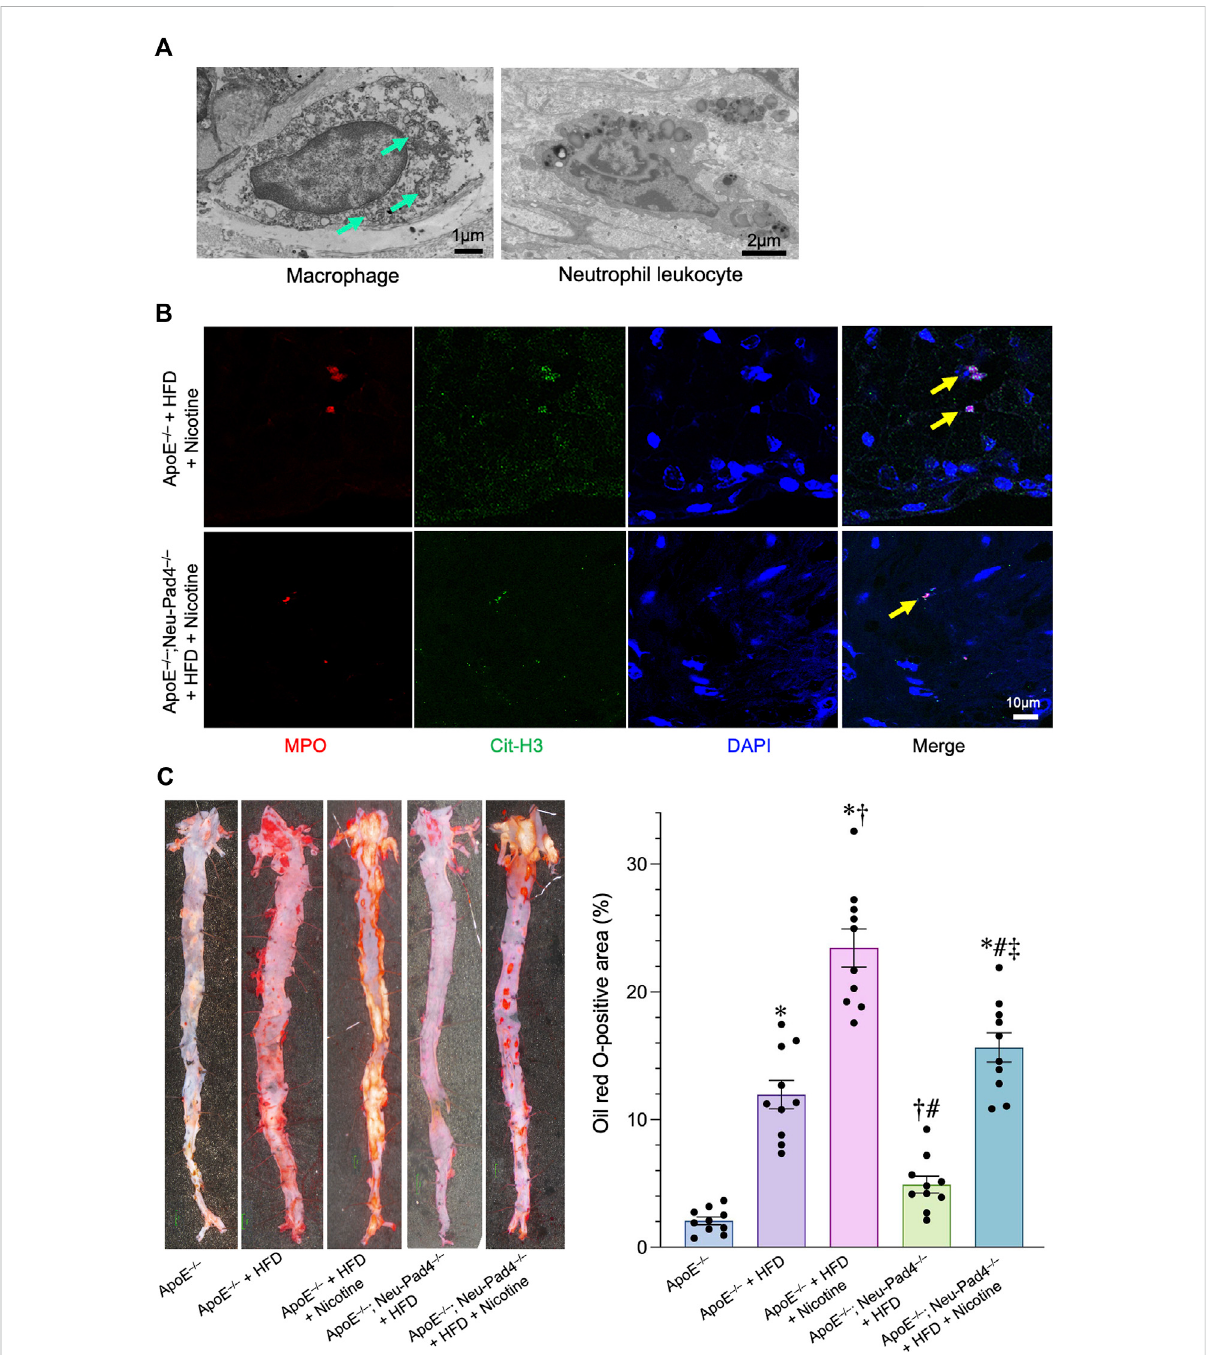
FIGURE 3 Role of NETs in the progression of atherosclerosis in high-fat diet (HFD)-fed apolipoprotein E knockout ( ApoE − / − ) mice. (A) Upper left panel: A representative transmission electron microscopic image of autophagosomes (arrows) in the macrophage derived from the atheroma of HFD-fed ApoE − / − mice.Upperrightpanel:Arepresentativetransmissionelectronmicroscopicimageoftheneutrophilleukocytederivedfromtheatheromaof HFD-fed ApoE − / − mice. (B) Representative confocal immuno fl uorescence images of aortic sections from the indicated mice stained for myeloperoxidase(MPO,red),citrullinatedhistone3(Cit-H3,green),andDNA(DAPI,blue). (C) Rightpanel : representativeimagesoftheaorta enface derived from HFD-fed ApoE − / − mice, ApoE − / − ; Neu-Pad4 − / − mice, or untreated ApoE − / − mice, stained with Oil Red O. Right panel : quanti fi cation of aortic en face plaque area in HFD-fed ApoE − / − mice, ApoE − / − ; Neu-Pad4 − / − mice, or untreated ApoE − / − mice, as shown in the representative images. *p < 0.05vs.Wild-type(Bluebar), † p < 0.05vs. ApoE − / − +HFD(Purplebar), # p < 0.05vs. ApoE − / − +HFD+Nicotine(Pinkbar), ‡ p < 0.05vs. ApoE − / − ;Neu- Pad4 − / − + HFD (Green bar), n = 10 in each group. Data are expressed as dot plots and bars, with lines indicating the mean ±